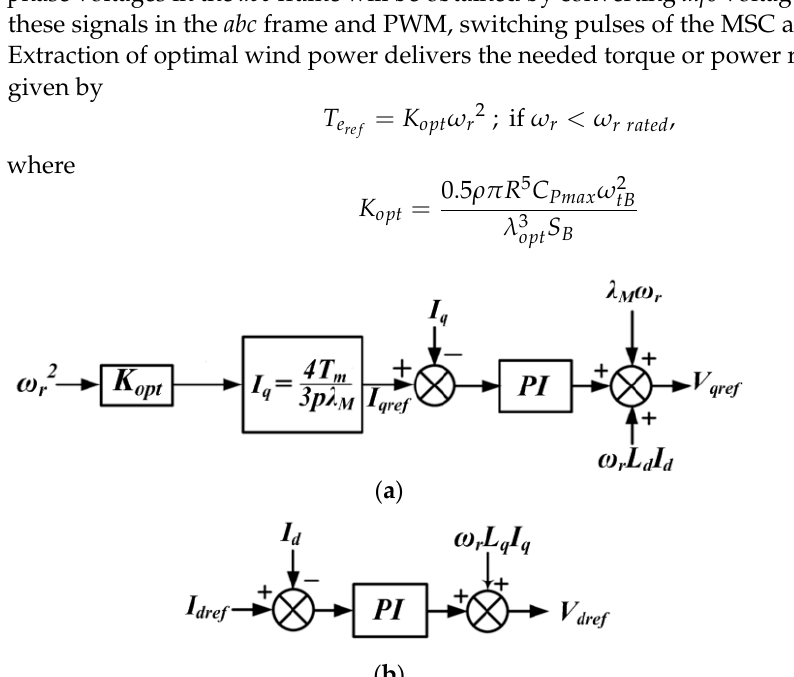
Figure 5. ( a ) q -axis control block; ( b ) d -axis control block of MSC.